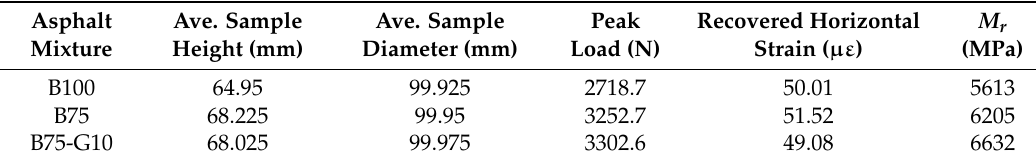
Table 11. Result of resilient modulus test in accordance with AS 2891.13.1